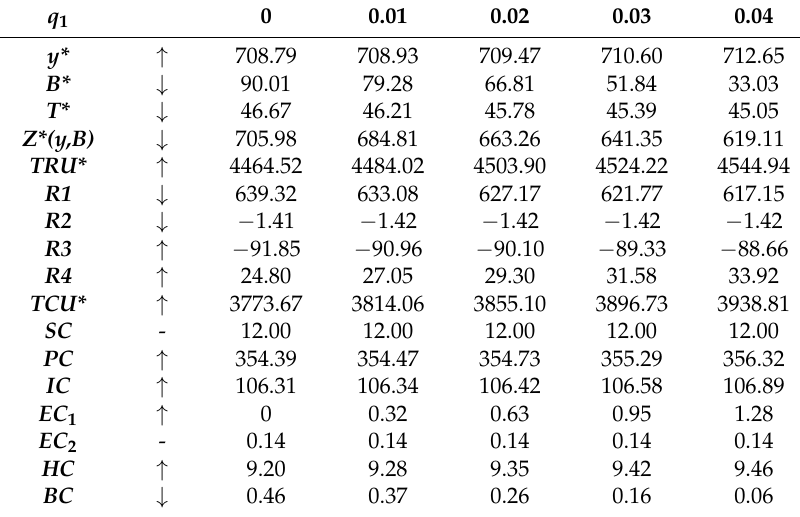
Table 7. Impact of q 1 on an optimal replenishment